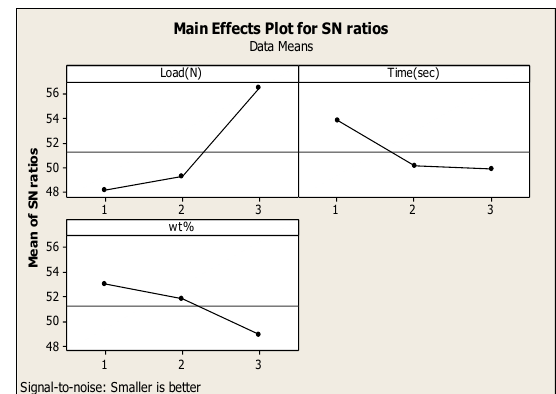
Figure 13: Main effect plots for SN ratio - Wear rate at low speed. Source: Authors, (2022). Main Effects Plot for Means Data